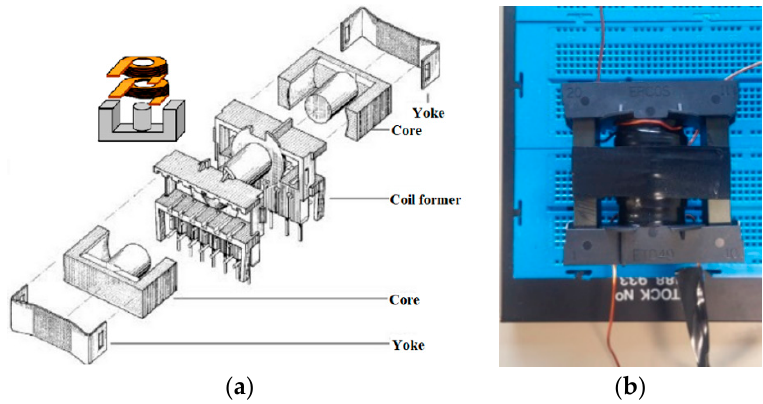
Figure 8. ( a ) Exploded drawing of the coupled inductor; ( b ) picture of assembled inductor.